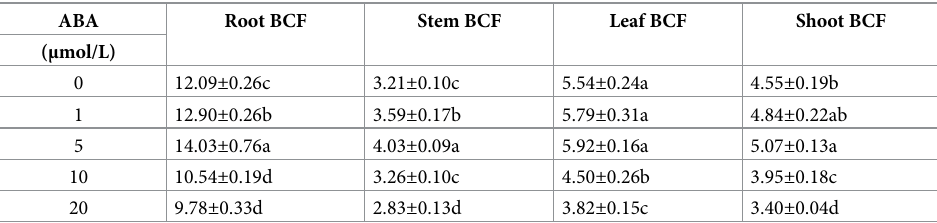
Table 5. BCF of P . frutescens .